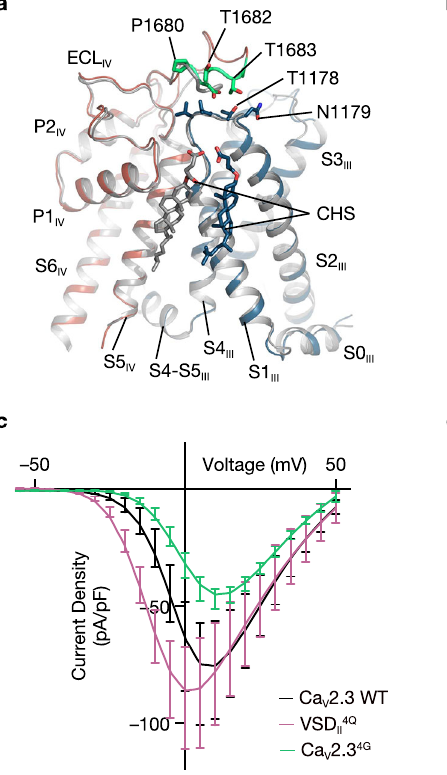
Fig.2|Voltage-sensingdomainsoftheCa V 2.3complex.a Superimpositionofthe VSDs (DIII) and the pore domains (DIV) of the Ca V 2.3 (red and blue) and Ca V 2.2 (gray)demonstratingtheinteractionbetweentheECL IV andtheVSD III .Residueson ECL IV in close contact with VSD III ( 1680 PDTT 1683 ) are shown in sticks and colored green.Cholesterylhemisuccinate(CHS)moleculesareshownassticksandlabeled. b Steady-state activation and inactivation curves of the wild-type (WT) Ca V 2.3 (black),VSD II 4Q (pink),andCa V 2.3 4G (green).Toexaminethevoltagedependenceof activation, HEK 293-T cells expressing the Ca V 2.3 complex were tested by 200-ms depolarizing pulses between – 60 and 50mV from a holding potential of – 100mV,